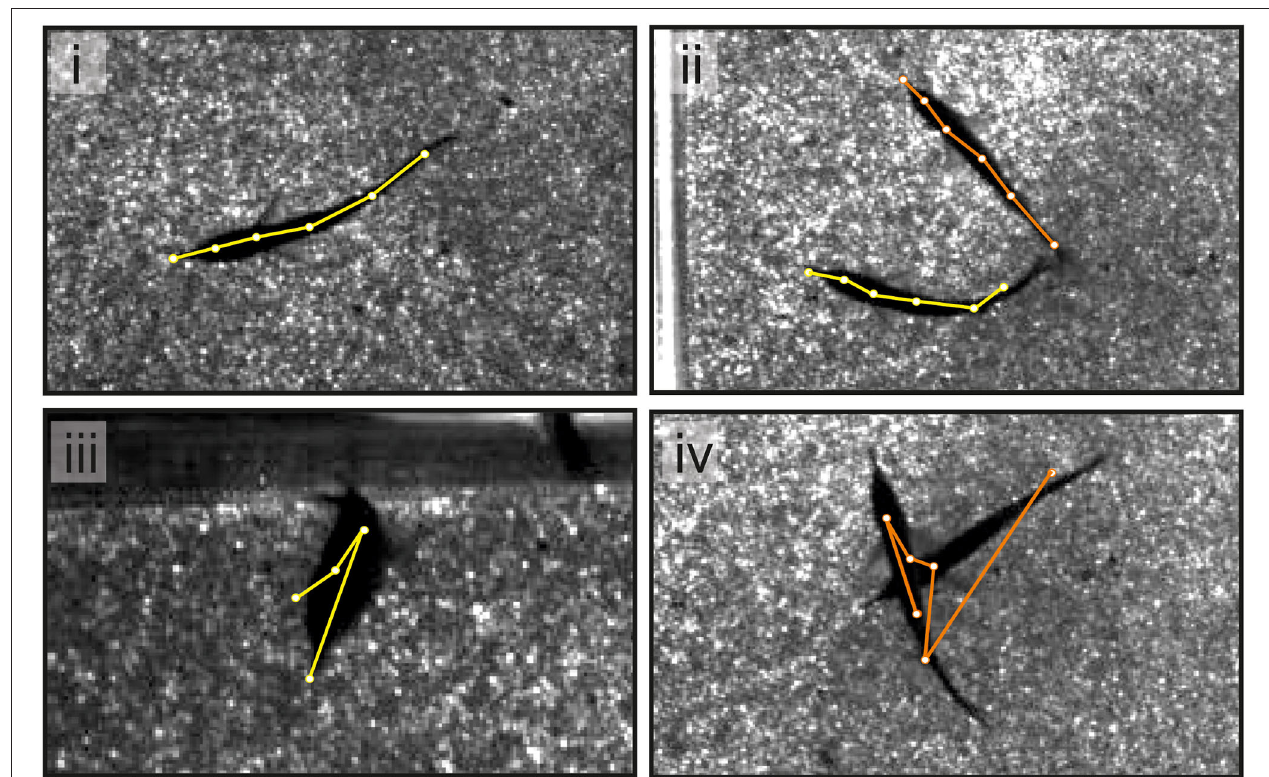
FIGURE 4 | An example of single video frames shows the superimposed skeletons tracked using SLEAP. In the majority of cases (see i,ii ), the tracking using SLEAP was sufficiently precise. When tracking a single fish, the error rate was low and errors occur when fish took unusual postures (see iii ). For dyadic interactions, errors were more frequent and dependent on the distance between animals (see iv